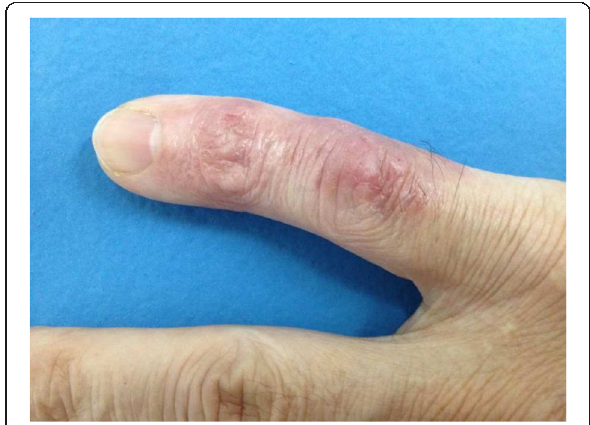
Figure 1 Erythematous-brown plaque, hardened and rough, with some reddish-honey colored crusts on the dorsum of the fifth right finger, before